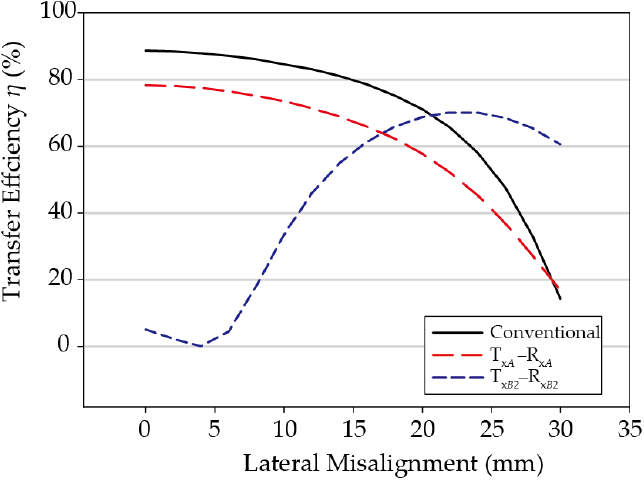
Figure 4. Simulated results of multilayer coils.